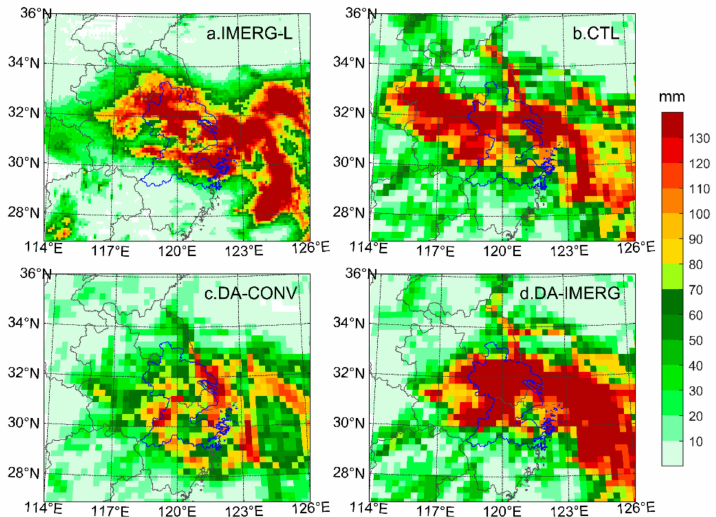
Figure 8. Precipitation accumulation of IMERG-L ( a ), CTL experiment ( b ), DA-CONV experiment ( c ),